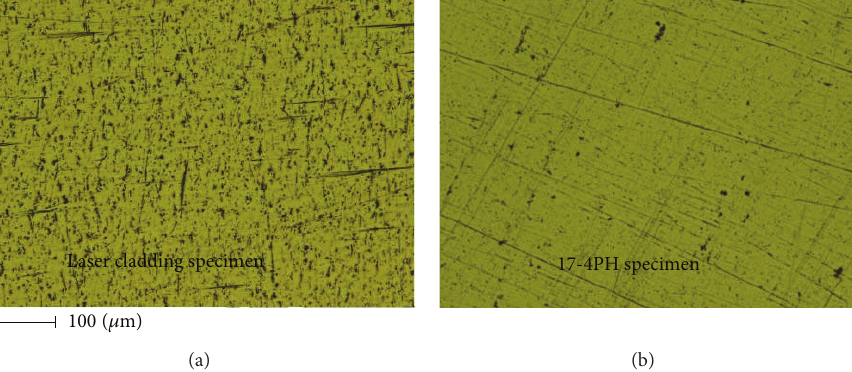
Figure 13: 500 times magnification of two specimens after impact.